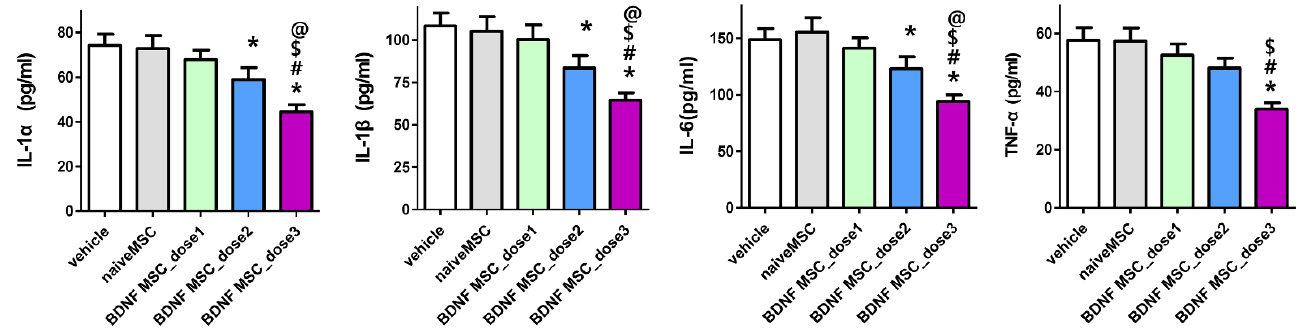
Figure 4. Brain inflammatory cytokines after hypoxic ischemic injury and MSC transplantation. (A) Levels of inflammatory cytokines including interleukin (IL)-1 α , IL- β , and IL-6, and tumor necrosis factor (TNF)- α in total brain tissue homogenates at 3 days after modeling. Data are expressed as mean ± standard error of the mean. * p < 0.05 compared to the HI + vehicle control, # p < 0.05 compared to the HI + naïve MSCs, $ p < 0.05 compared to HI + BDNF-eMSCs at dose 1 (approximately 1 × 10 4 cells), @ p < 0.05 compared to HI + BDNF-eMSCs at dose 2 (approximately 5 × 10 4 cells). Abbreviations: vehicle, HI + vehicle control, naïve MSCs; HI + naïve MSCs, BDNF MSC_dose1; HI + BDNF-eMSCs at 1 × 10 4 cells dose; BDNF MSC_dose2; HI + BDNF-eMSCs at 5 × 10 4 cells dose; BDNF MSC_dose3; HI + BDNF-eMSCs at 1 × 10 5 cells dose.